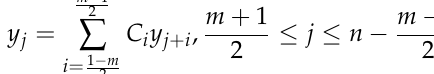
Figure 8. Preheating phase analysis of one batch of product.